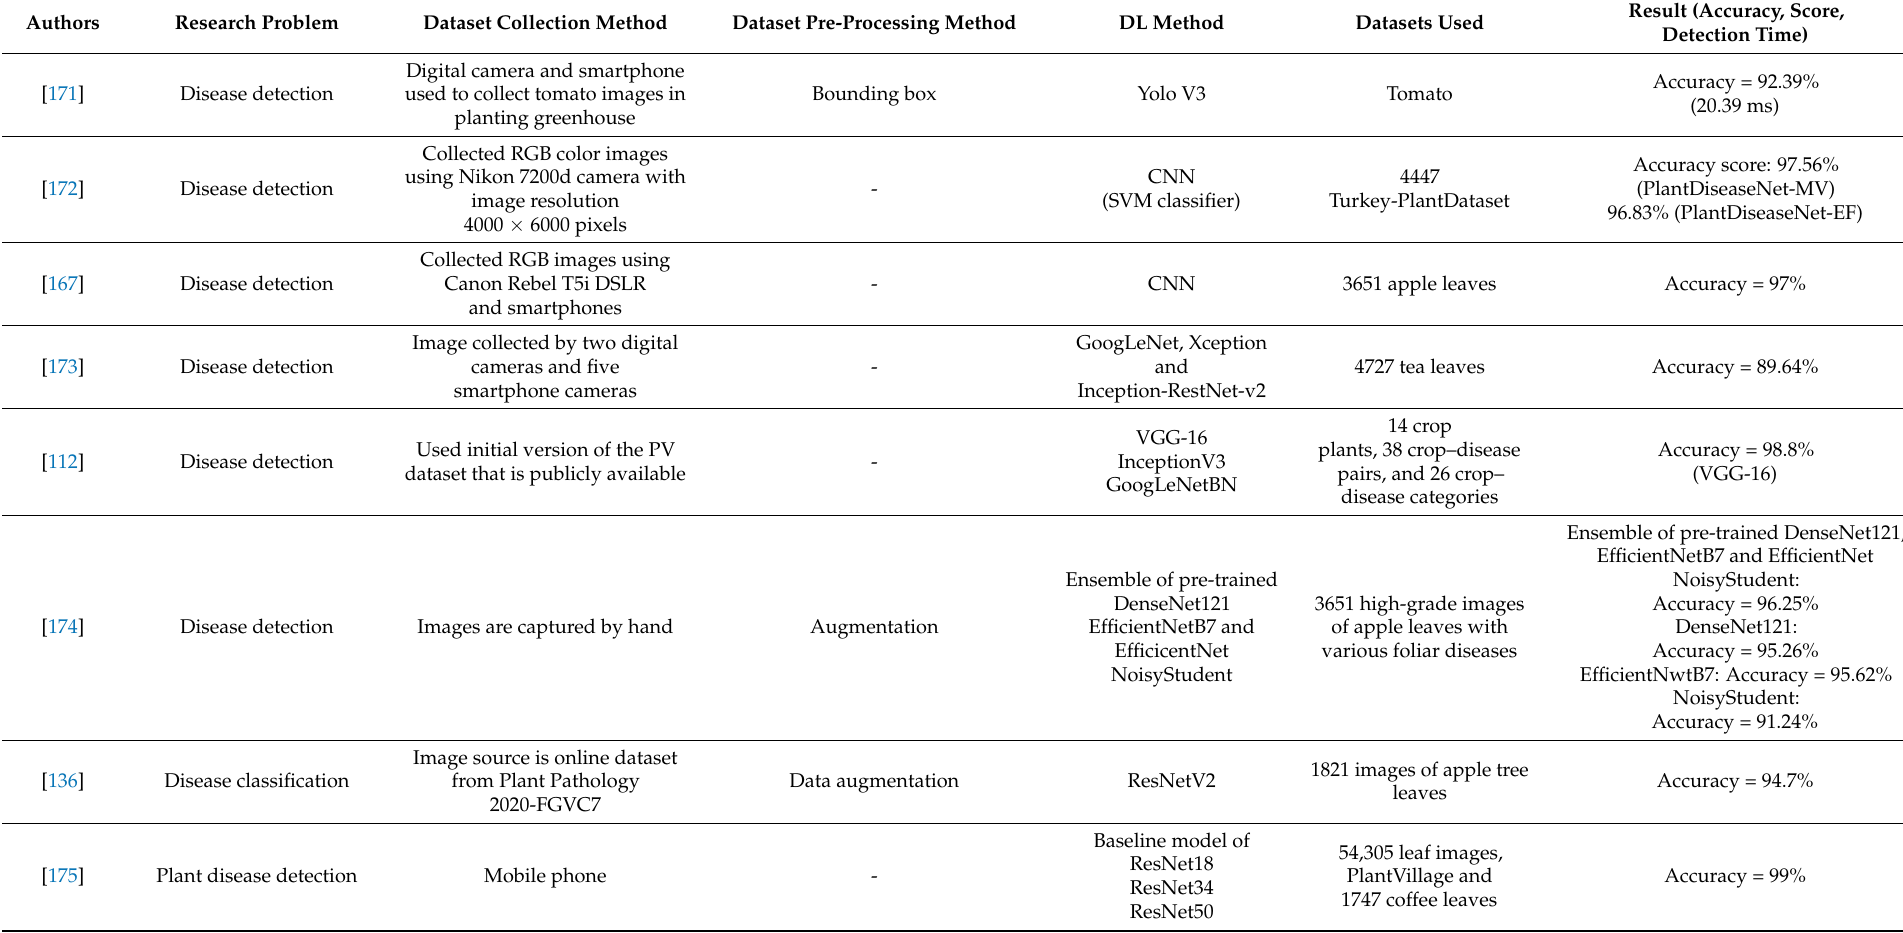
Table 2. Summary of previous studies on deep learning